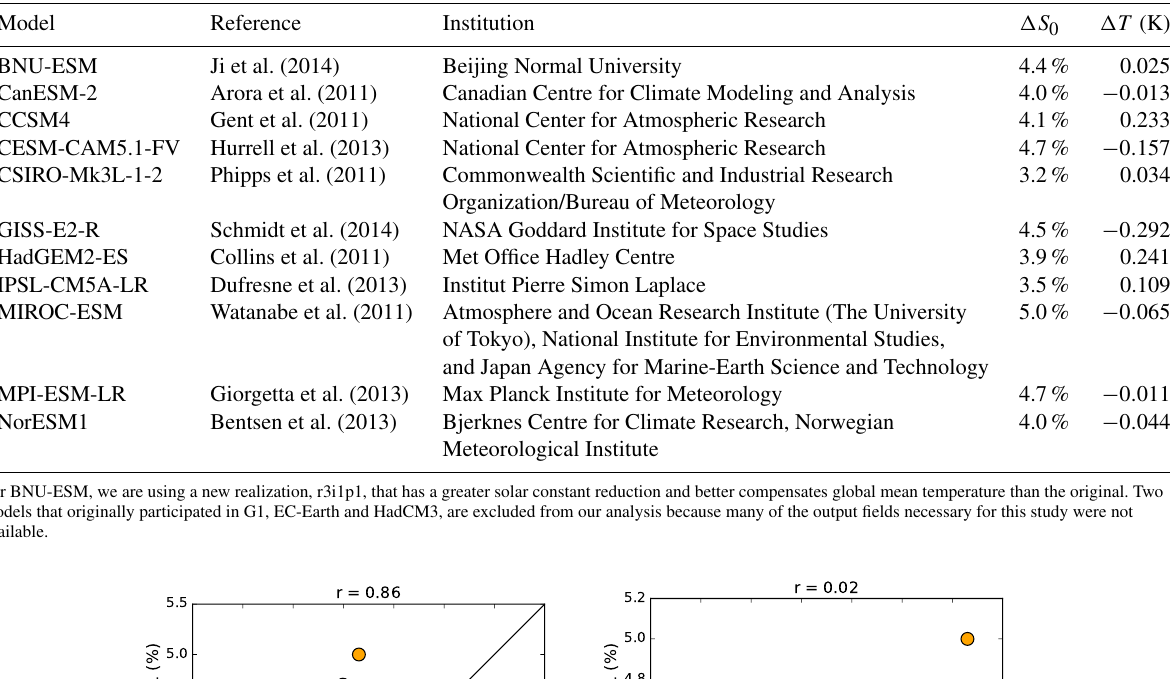
Table 1. Models included in this study, with references, institutions, solar constant reduction in the G1 experiment ( (cid:49)S 0 ), and global mean surface air temperature change in G1 – piControl ( (cid:49)T ). All models have a full dynamical ocean coupled to the atmosphere.